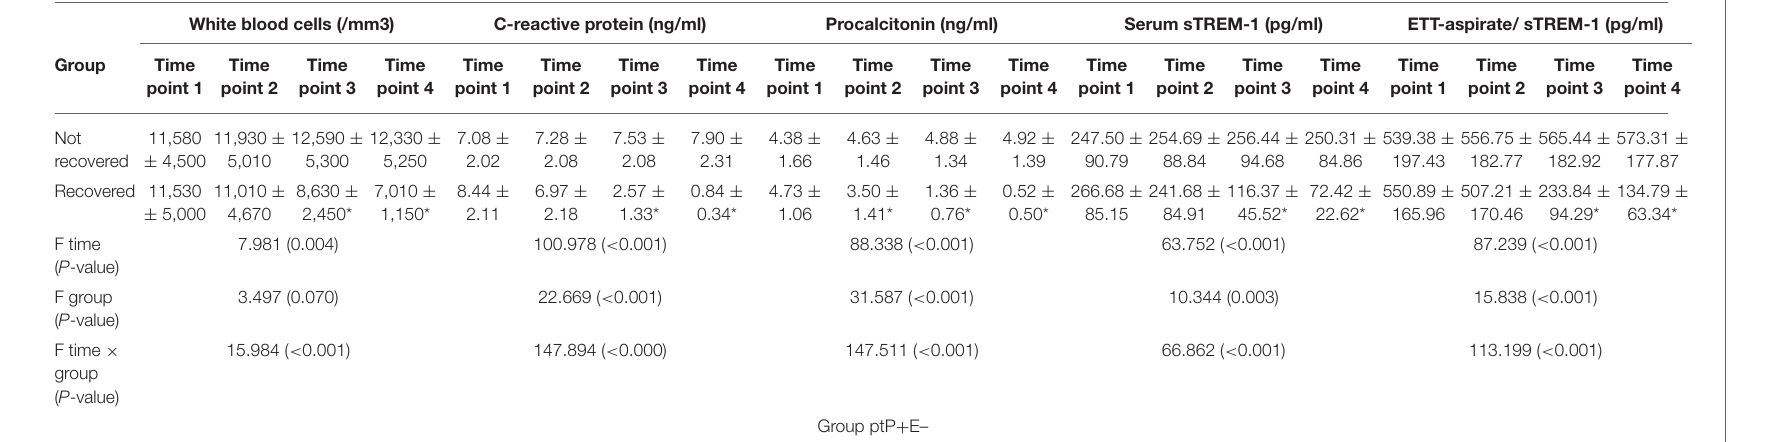
TABLE 3 | Repeated measures ANOVA of indicators in groups ptP + E– and ftP + E–. White blood cells (/mm3) C-reactive protein (ng/ml) Procalcitonin (ng/ml) Serum sTREM-1 (pg/ml) ETT-aspirate/ sTREM-1